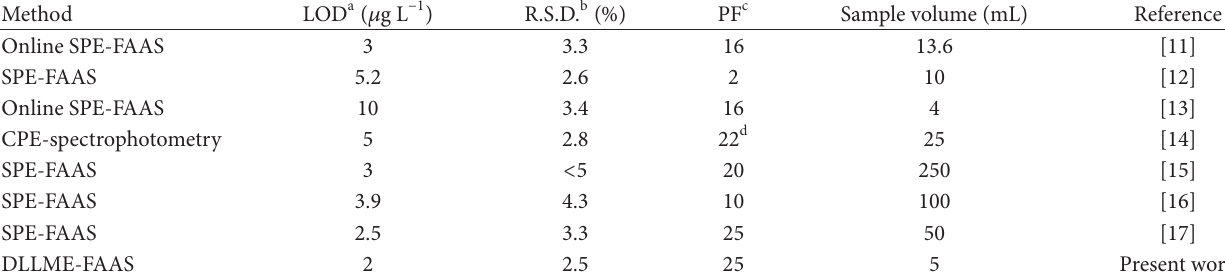
T 1: Comparison of DLLME with other extraction methods for determination of copper in water